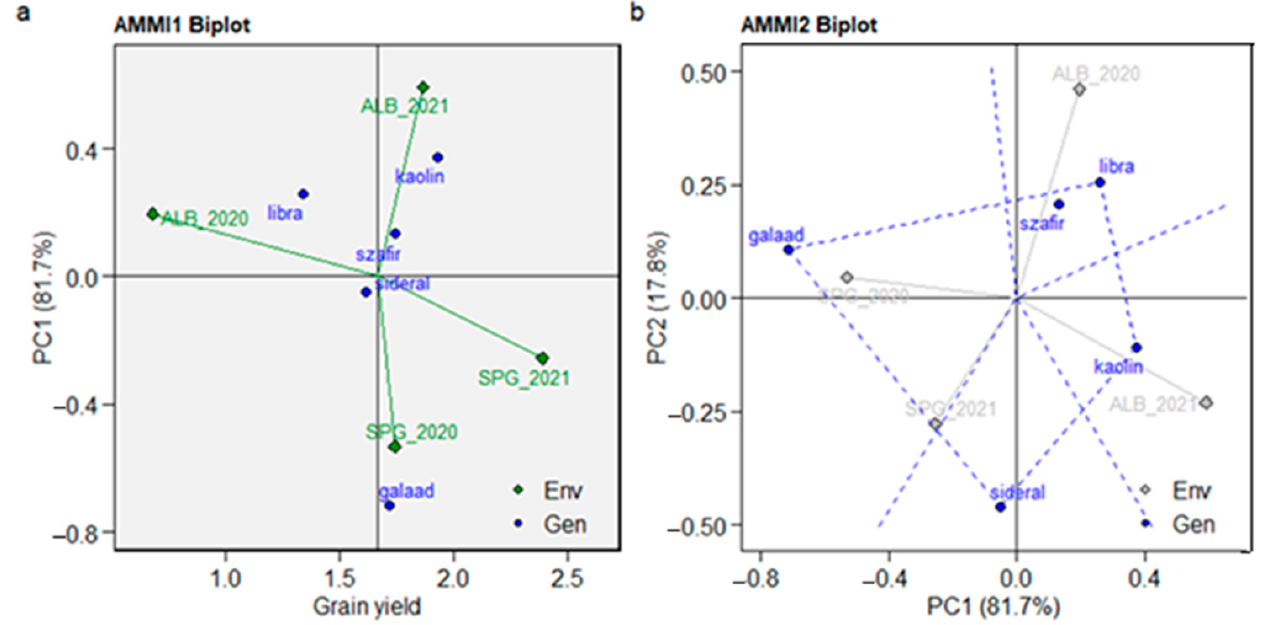
Figure 5. AMMI1 ( a ) and AMMI2 biplot ( b ) analysis for genotype by environment (G × E) interaction in multilocation variety trials for the seed yield trait and ‘which-won-where polygon view’ of the genotypes and environments.